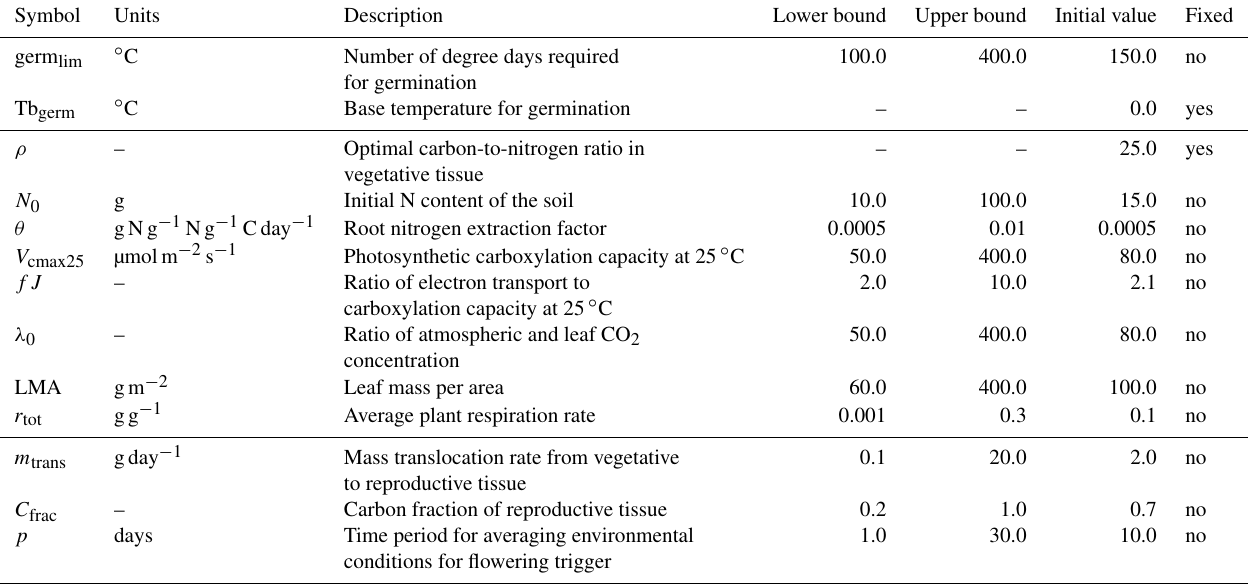
Table 2. Model parameters, upper and lower bounds and initial values used in the model-fitting procedure. Symbol